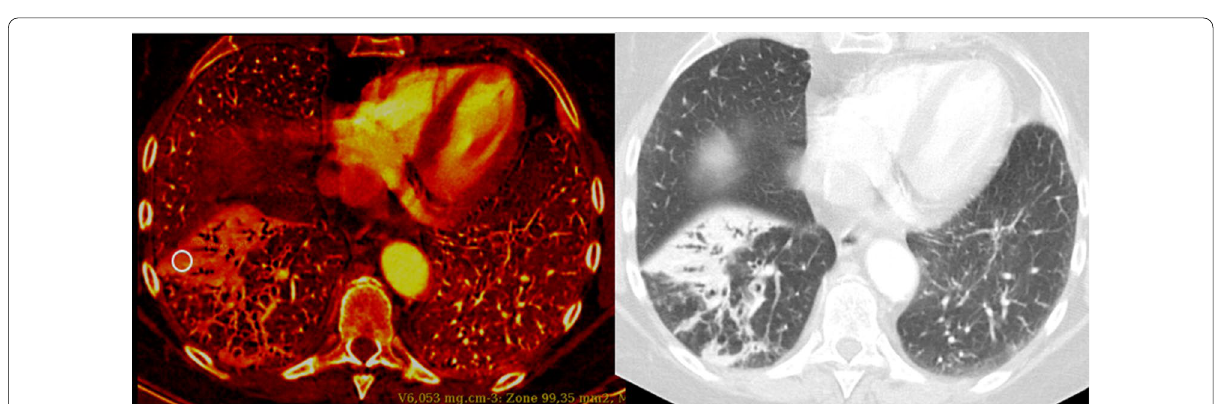
Fig. 3: 19‑year‑old male with hemoptysis and chest pain. A homogeneous perfusion defect (PD consolidation (conventional lung images, right). Tuberculous pneumonia was confirmed by PCR assay performed a on sputum sample. Iodine concentration was measured at 0.839 mg/cm 3 within the circle and at 0.686 mg/cm 3 within the normal‑appearing parenchyma